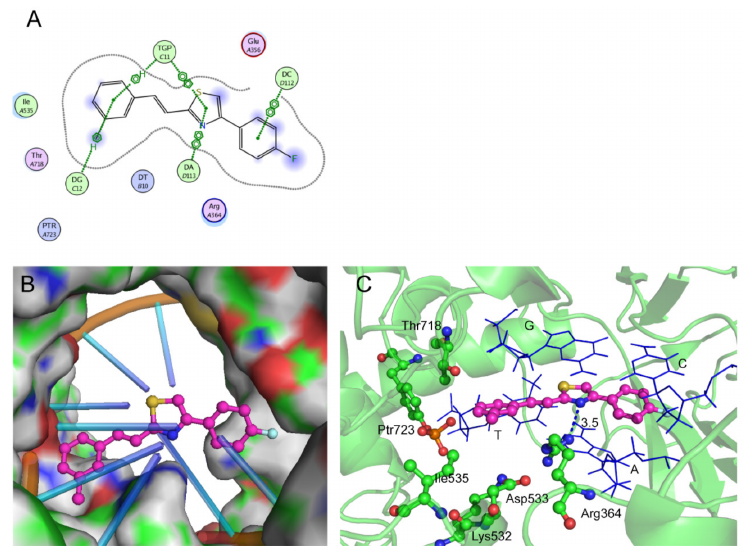
Figure 4. Hypothetical binding mode of 8 in a ternary complex with DNA and Top1 (derived from PDB ID: 1K4T). 2D-ligand interactions ( A ), ball-and-stick model ( B ) and the 3D-ligand interactions ( C ) of 8 and the accepter in the binding pocket. All distances are measured from heavy atom to heavy atom. The carbon atoms of 8 are shown in purple, and the base pairs are displayed as blue